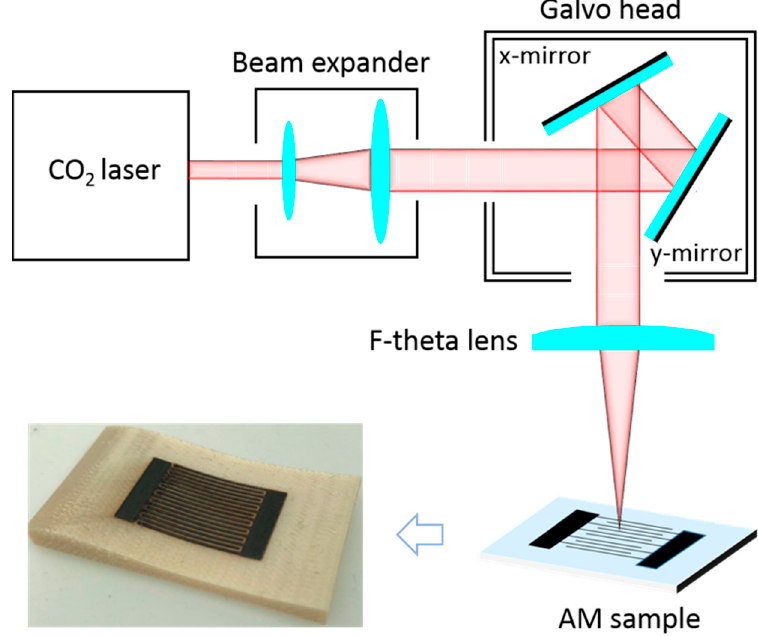
Figure 1. Experimental setup of the laser processing and an image of the laser-induced graphene (LIG) capacitor on the AM part.